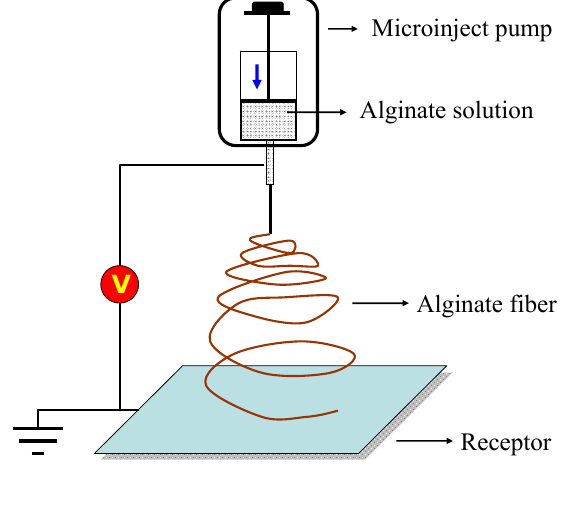
Figure 9. Illustration of electrospinning of an alginate fibrous